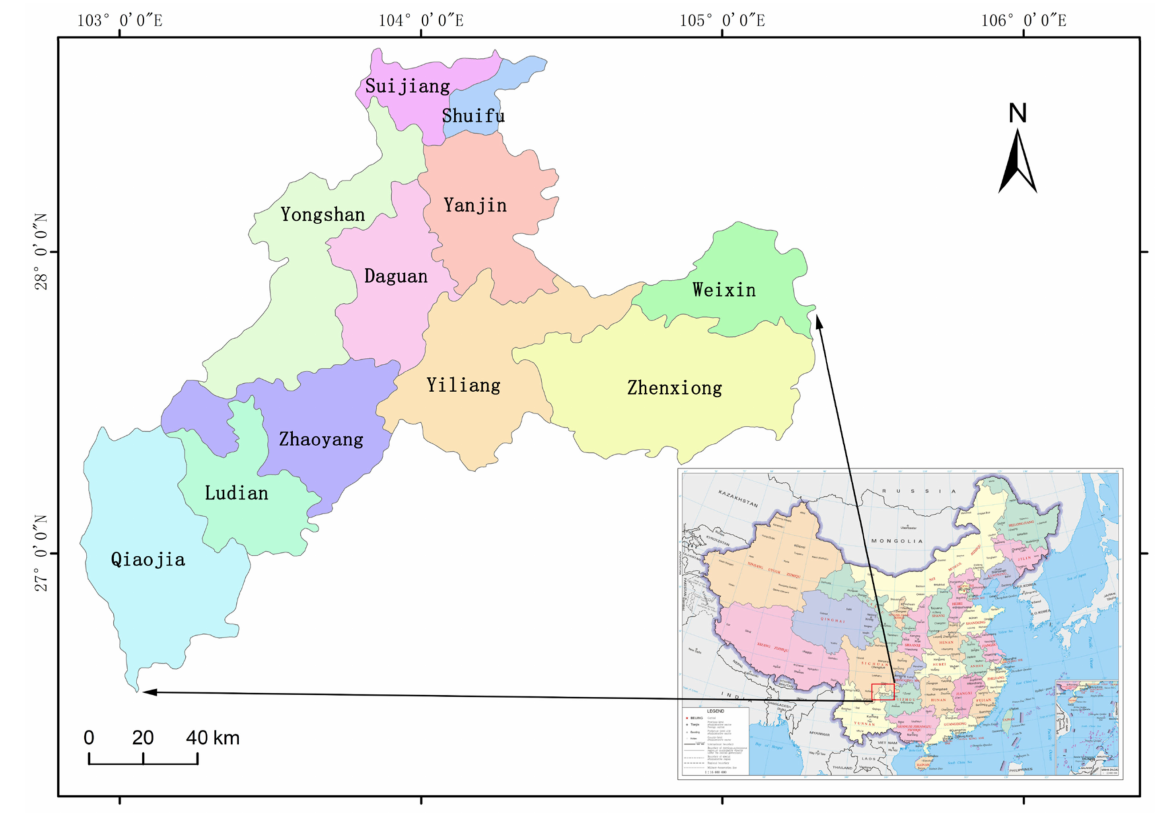
Figure 1. Study area of Zhaotong City, Yunnan